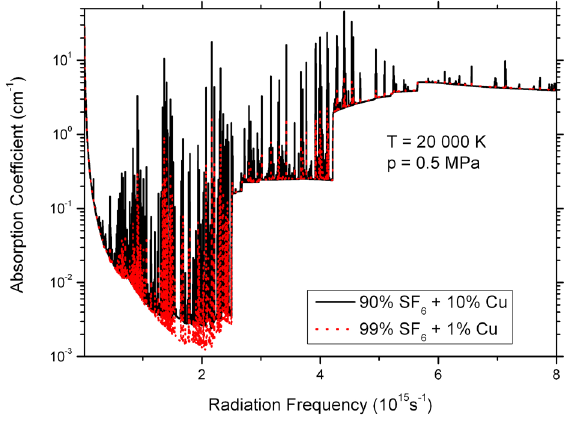
Figure 2: Total absorption coefficient for the SF at temperatures of 5 000 K and 20 000 K.